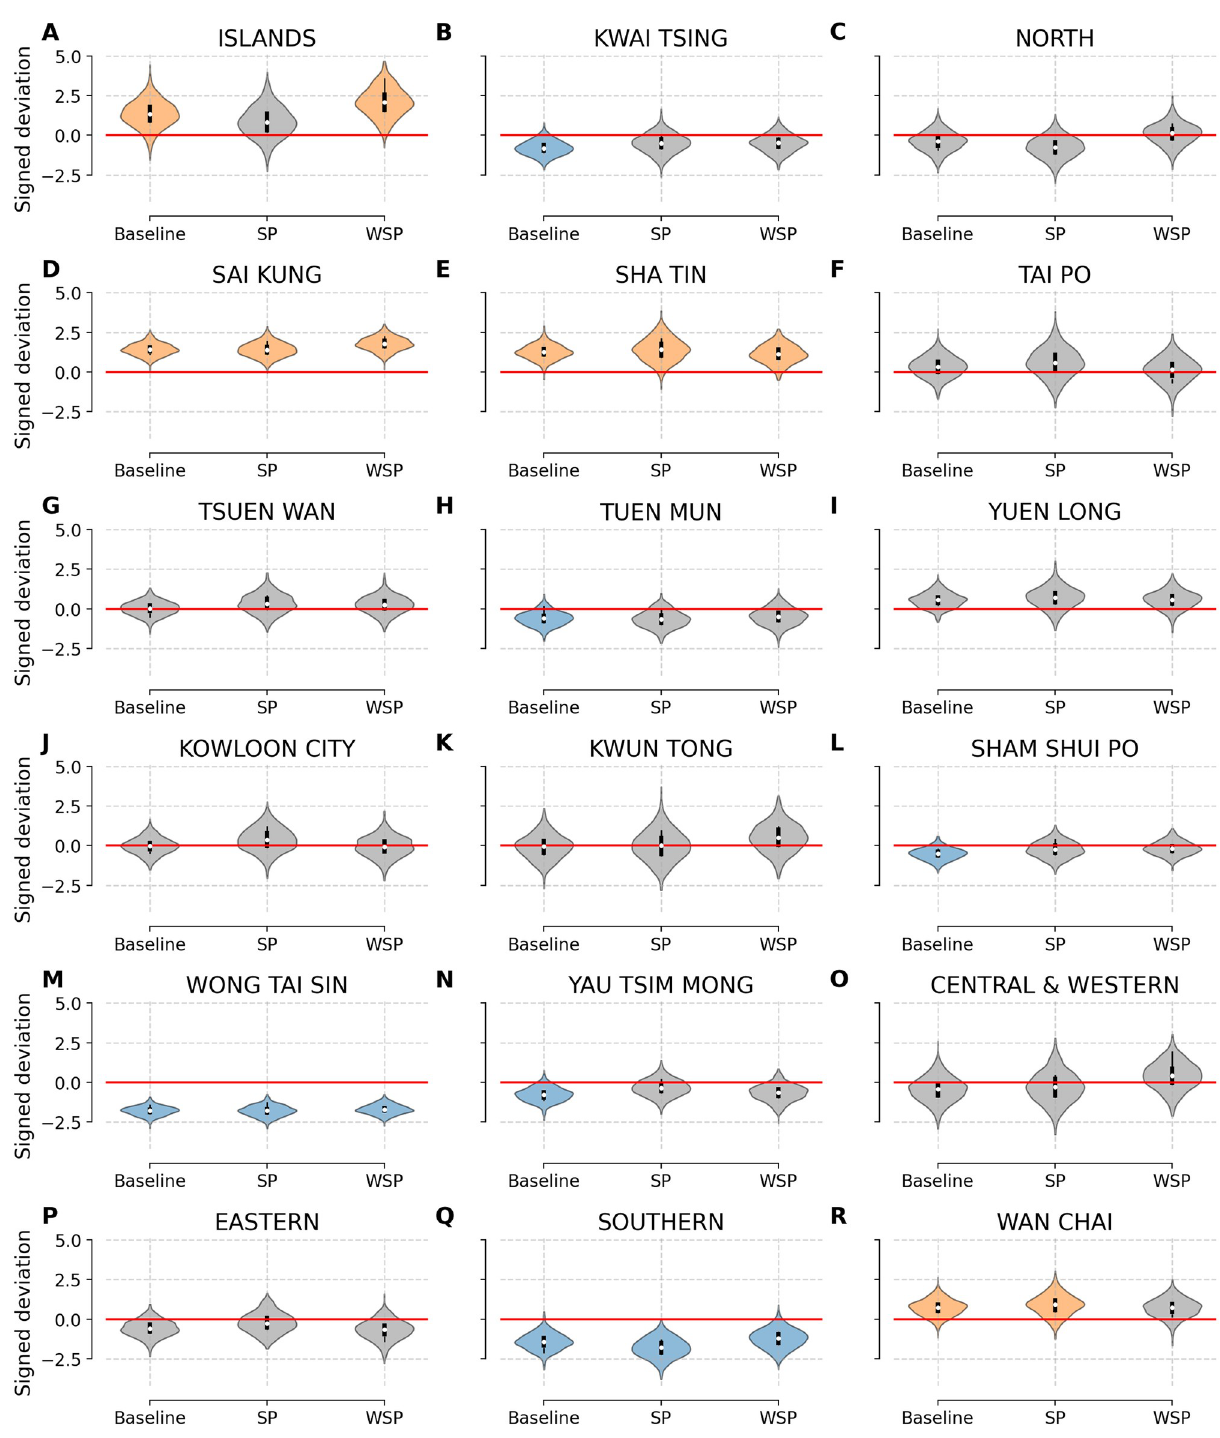
Fig 4. Relative likelihood of systematic bias for models trained on the default set of features in 2016. We examine the distribution of probable outcomes of signed deviation by computing the difference between our predictions ^ Y 2016 perfect model would have a narrow distribution centred on 0 (solid red line going across). Positive values show overestimation, whereas negative values show an underestimation of mortality rates for each district. We color models with significance systematic overestimation in orange, while use blue to highlight models with significance systematic underestimation as measured by the 80% CI.